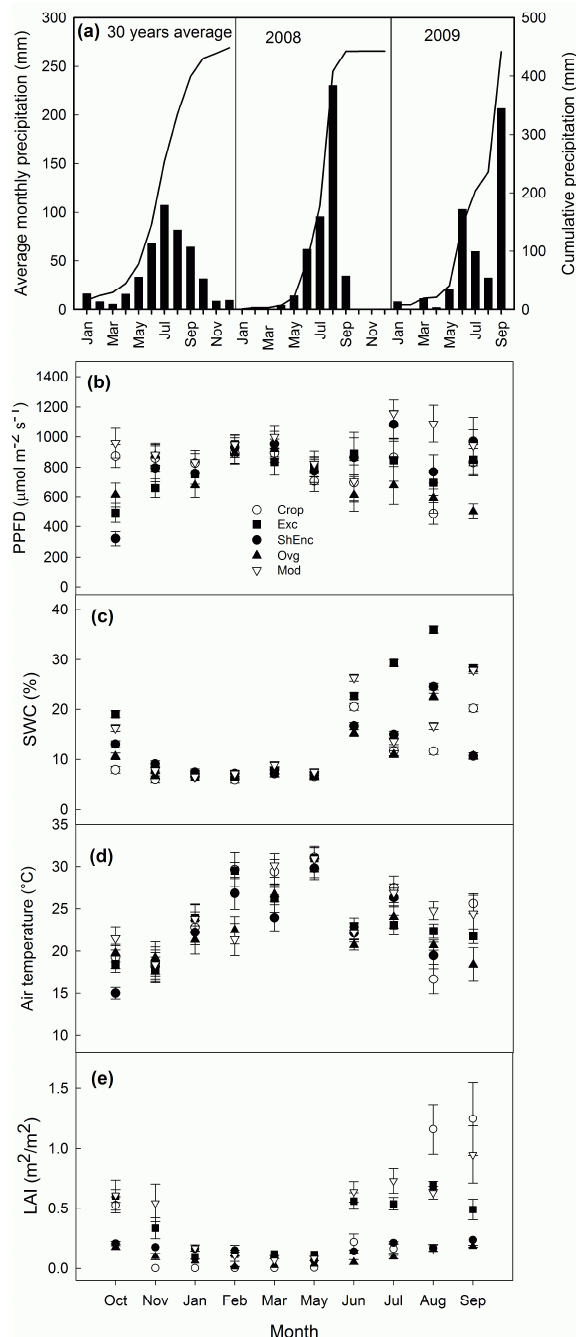
Fig. 2. (a) Average monthly and annual cumulative precipitation over a 30yr period (left panel) and during the study period October 2008–July 2009 (central and right panels) in Los Llanos de Ojuelos, Mexico. Monthly time series from October 2008 to September 2009 depicting (b) PPFD, (c) SWC, (d) T a , and (e) LAI at five contrasting land use types in the shortgrass steppe in central Mexico. All points represent the mean ± 1SE. Acronyms stand for Crop = oat crop, Exc = exclosure, ShEnc = shrub encroachment, Ovg = overgrazing and Mod = moderate